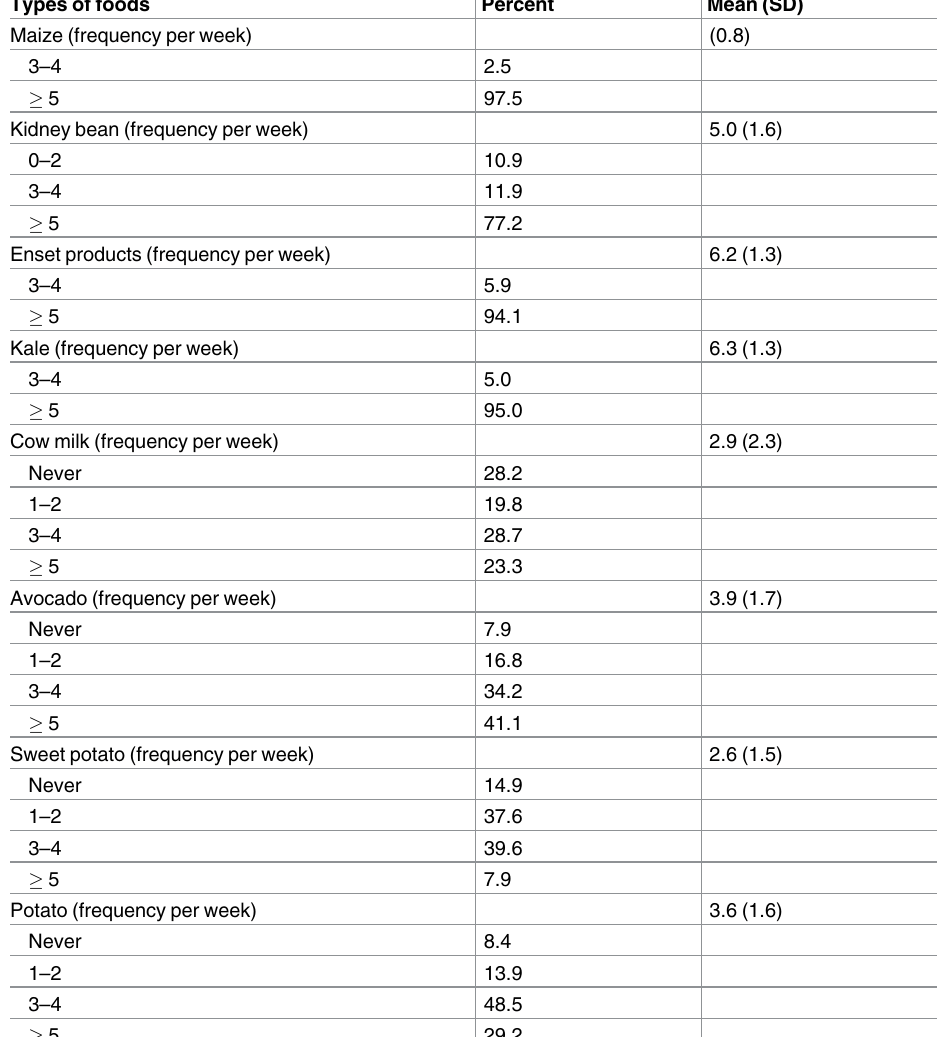
Table 3. Frequency of consumption by women of foods commonly available in Sidama zone, south- ern Ethiopia (n = 202). Types of